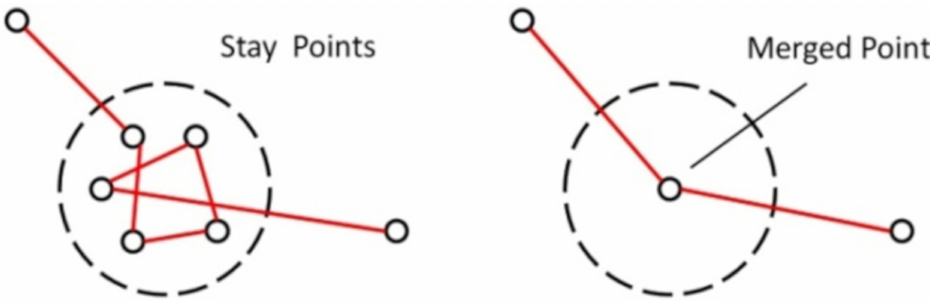
Figure 1. Merging detected stay-points in a